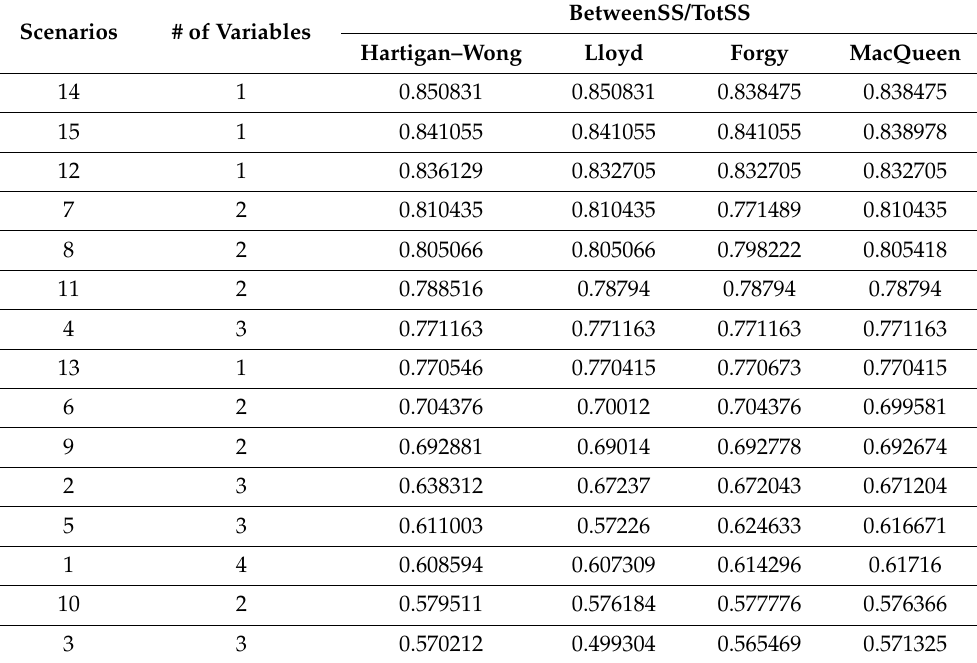
Table 5. Results of clustering analysis by scenario (in the order of the Hartingan–Wong value).